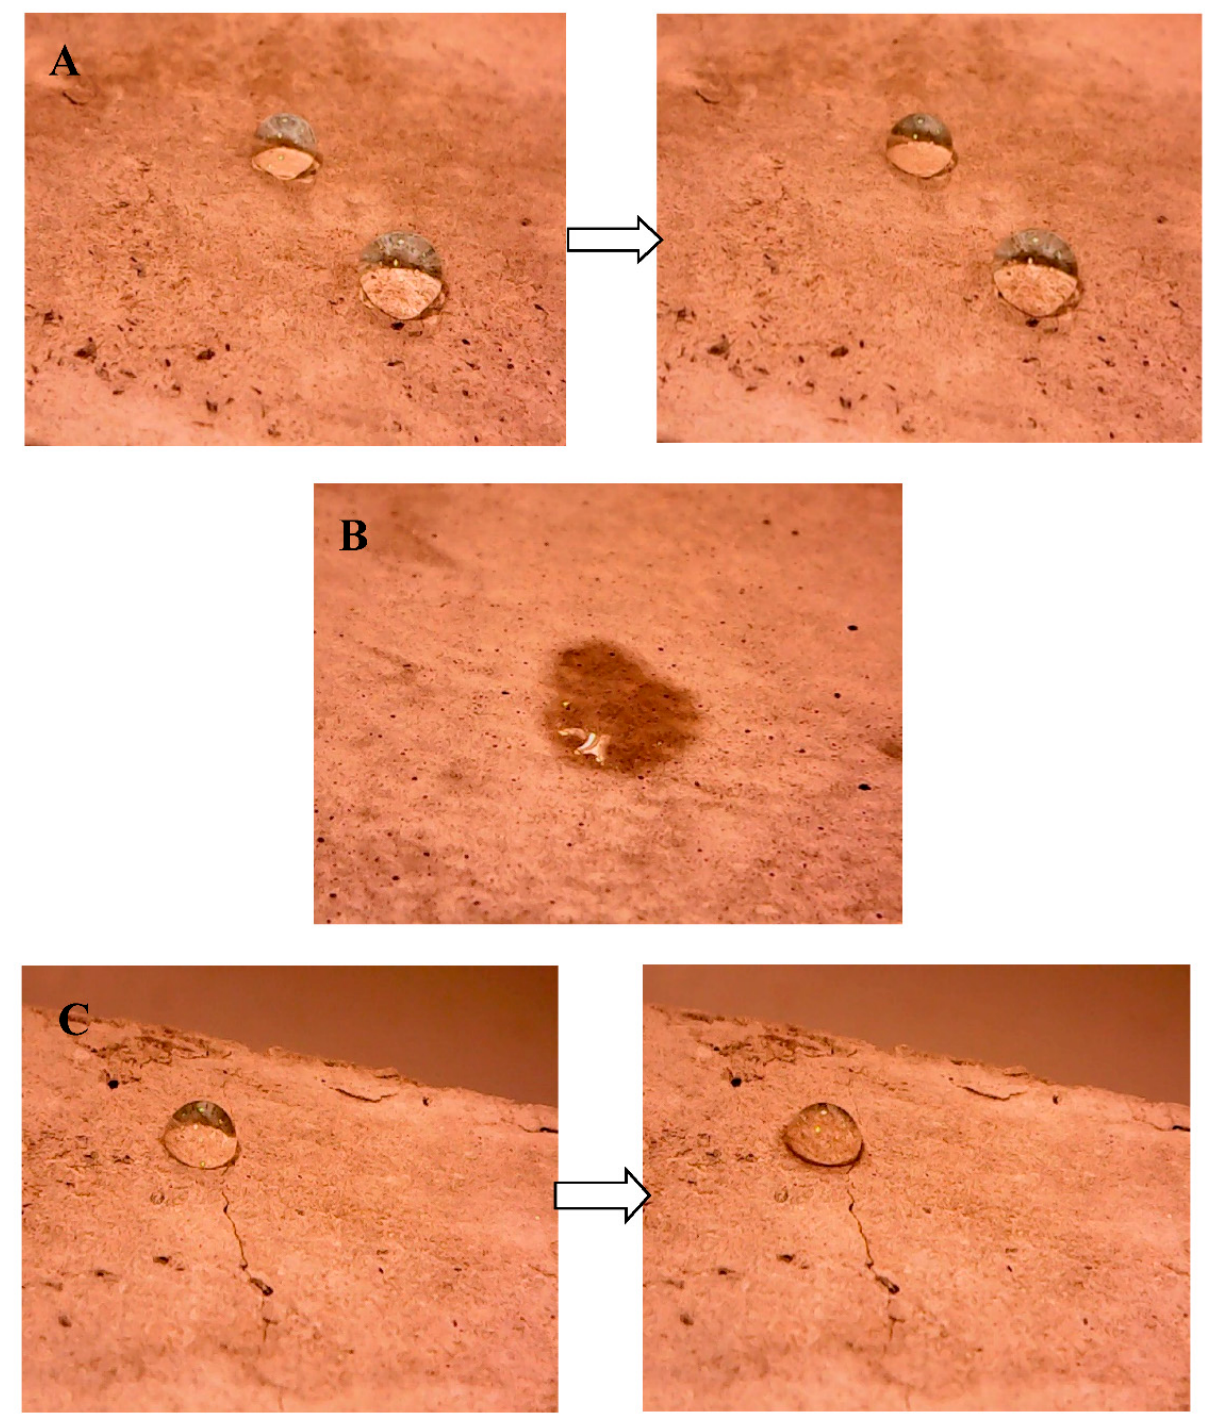
Figure 13. Wettability tests on the side surface of ( A ) TR F sample (sample 1) at t = 0 s ( left ) and at t = 150 s ( right ), ( B ) P sample (sample 10) at t = 1 s, ( C ) P/TR F sample (sample 11) at t = 0 s ( left ) and at t = 150 s ( right ).